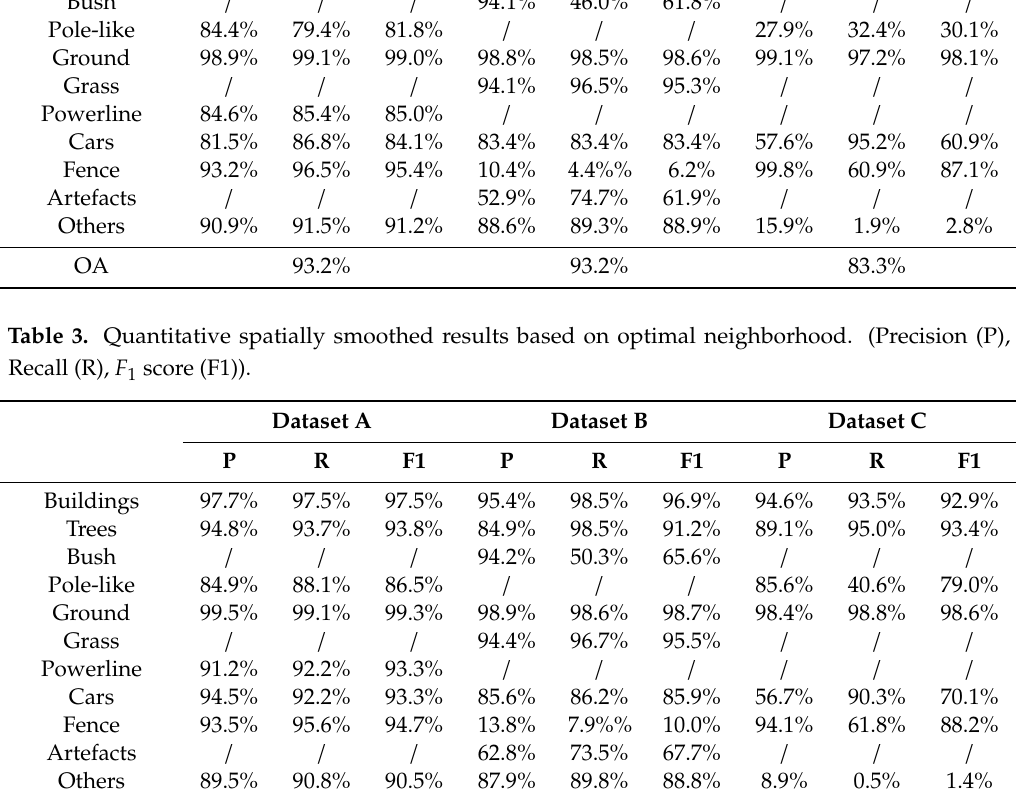
Table 2. Quantitative spatially smoothed results based on K-nearest neighbor. (Precision (P), Recall (R), F 1 score (F1)).